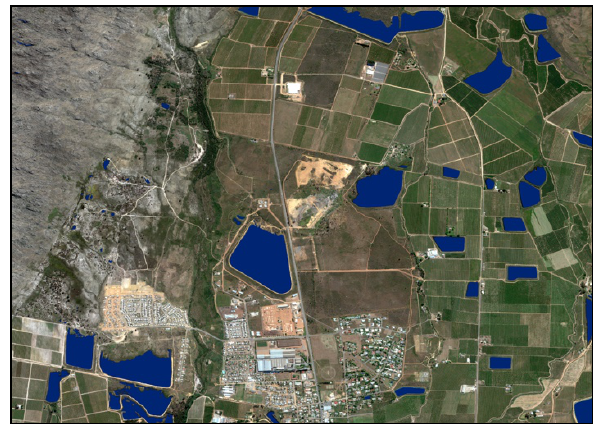
Figure 7. Classification of waterbodies (blue segments) ©WorldView-2 Image Copyright 2014, DigitalGlobe.